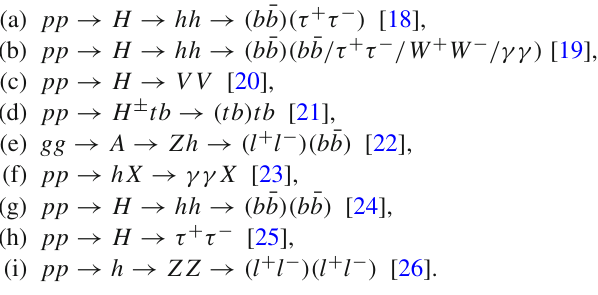
YukawatypeI(top)andII(bottom)anddifferentvaluesof m 2 ted grey lines correspond to contours with the same χ 2 for the 125